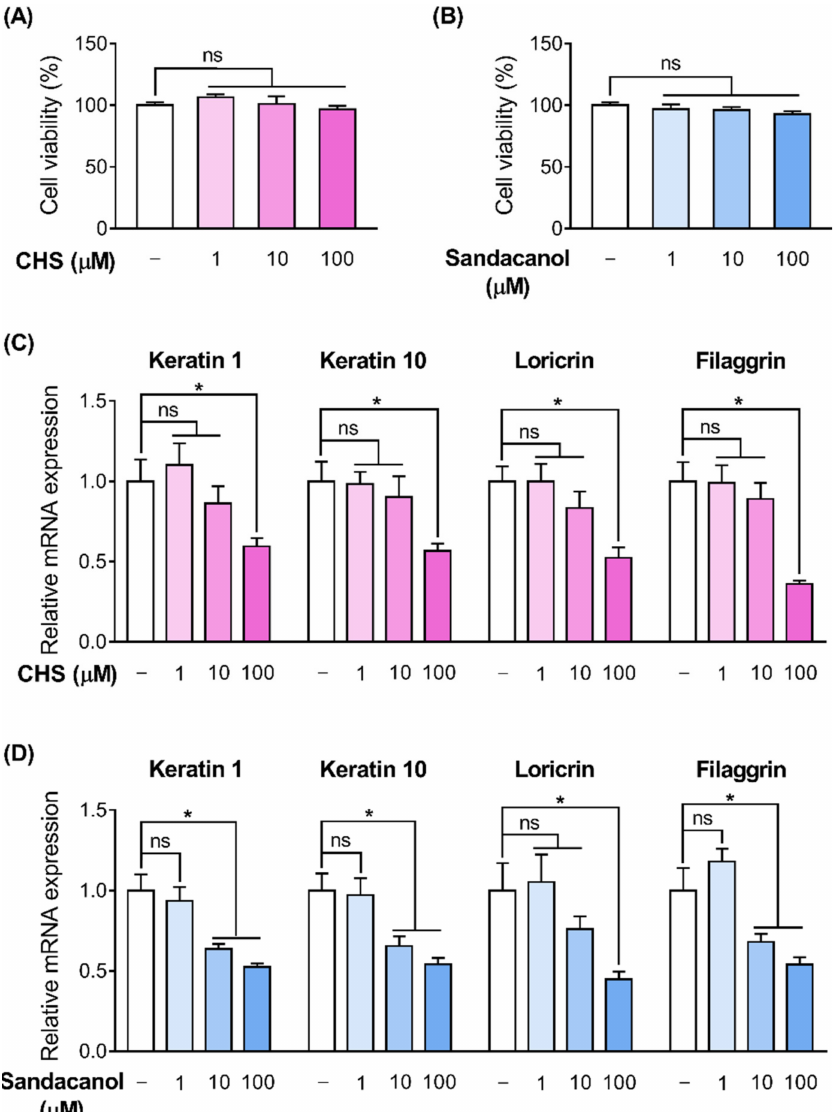
Figure 6. OR involvement in the skin barrier disruption pathway in HaCaT cells. The cells were cultured with vehicle, cyclohexyl salicylate (1, 10, or 100 µ M), or sandacanol (1, 10, or 100 µ M) for 48 h. Thereafter, ( A , B ) cell viability and ( C , D ) the relative mRNA expression of keratin 1 , keratin 10 , filaggrin , and loricrin were measured. Results are shown as mean ± SEM of three experiments. * p < 0.05, between the